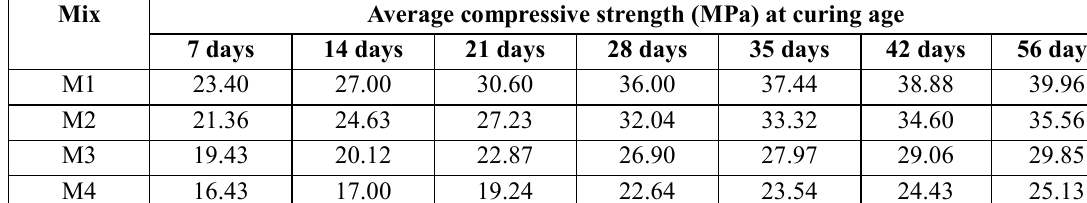
Average compressive strength of concrete mixes.